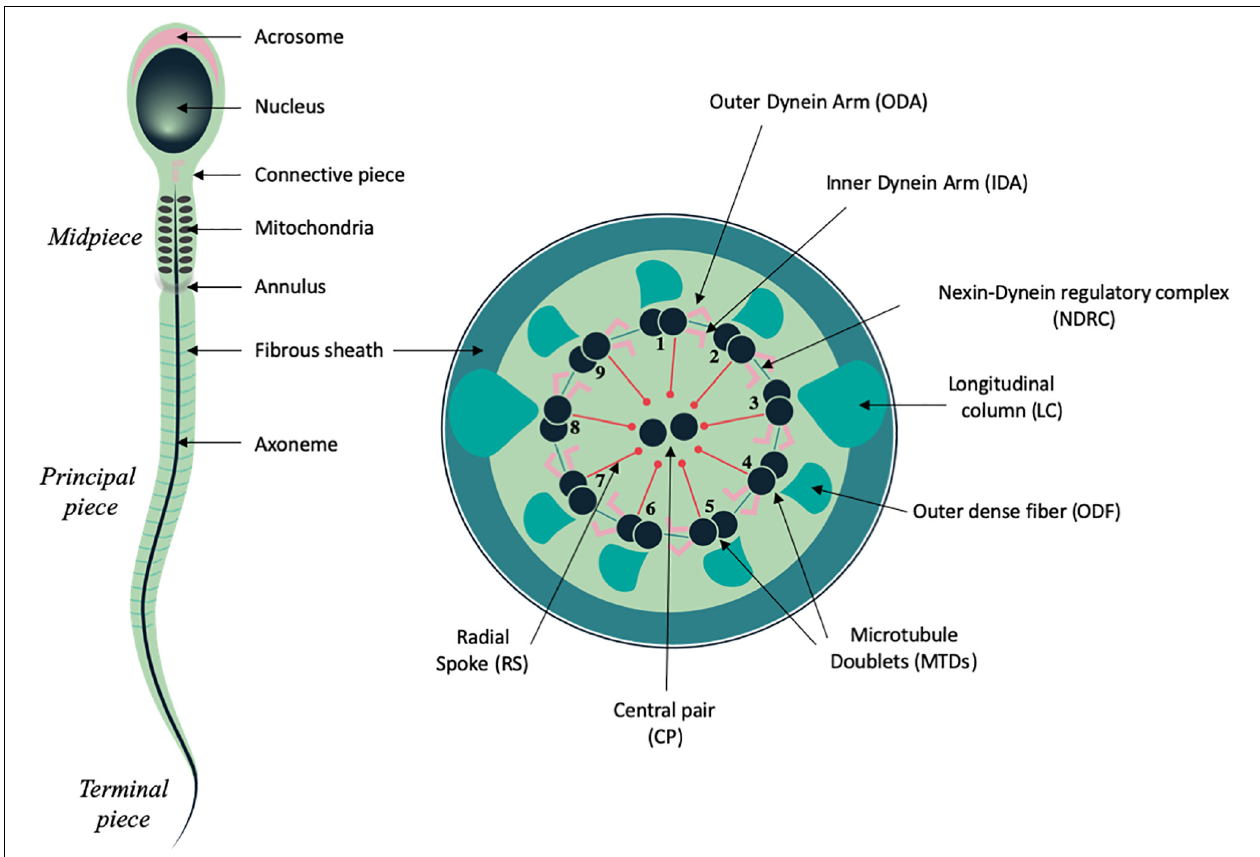
FIGURE 1 | Schematic representation of mammalian spermatozoa and flagellum structure. Left panel , overall view of the spermatozoa showing the main head and flagellum structures and compartments. Right panel , cross section from the principal piece of the flagellum showing the organization of the axoneme: microtubule doublets (MTD), central pair (CP), radial spokes (RS), nexin dynein regulatory complex (NDRC), inner and outer dynein arms (IDA and ODA), together with some of the peri-axonemal structures: fibrous sheath (FS), outer dense fiber (ODF), and longitudinal columns